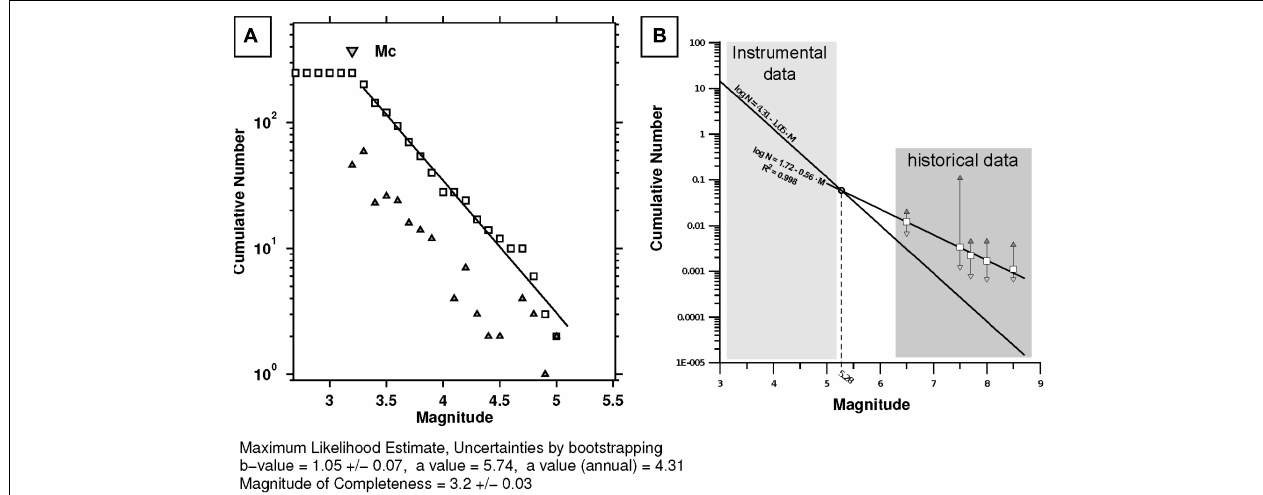
FIGURE 3 | (A) Gutenberg-Richter fit of the instrumental catalog after declustering of the catalog shown in Figure 2 (see details in the text). Triangles show discrete frequencies while the squares show the cumulative distribution. (B) Plot comparing the Gutenberg-Richter Law fitted with instrumental data (thin line) and the historical data. Squares are the mean annual frequencies, light-gray downward triangles are minimum frequencies and dark-gray upward triangles are maximum frequencies. The fitted Gutenberg-Richter Law to the historical data is shown as a thick line. The intersection between both fits takes place on the magnitude value M W =